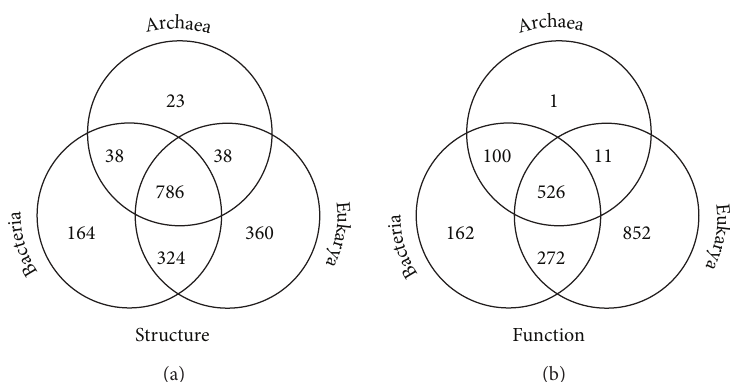
Figure 2: Global trends of trait sharing in Venn taxonomic groups. (a) Venn diagram displaying the distribution of 1,733 FSF domains in 981 completely sequenced proteomes sampled from 652 Bacteria, 70 Archaea, and 259 Eukarya. This constituted the structure dataset. (b) Venn diagram displaying the distribution of 1,924 terminal-level GOs in 249 free-living functionomes corresponding to 183 Bacteria, 45 Archaea, and 21 Eukarya. This constituted the function